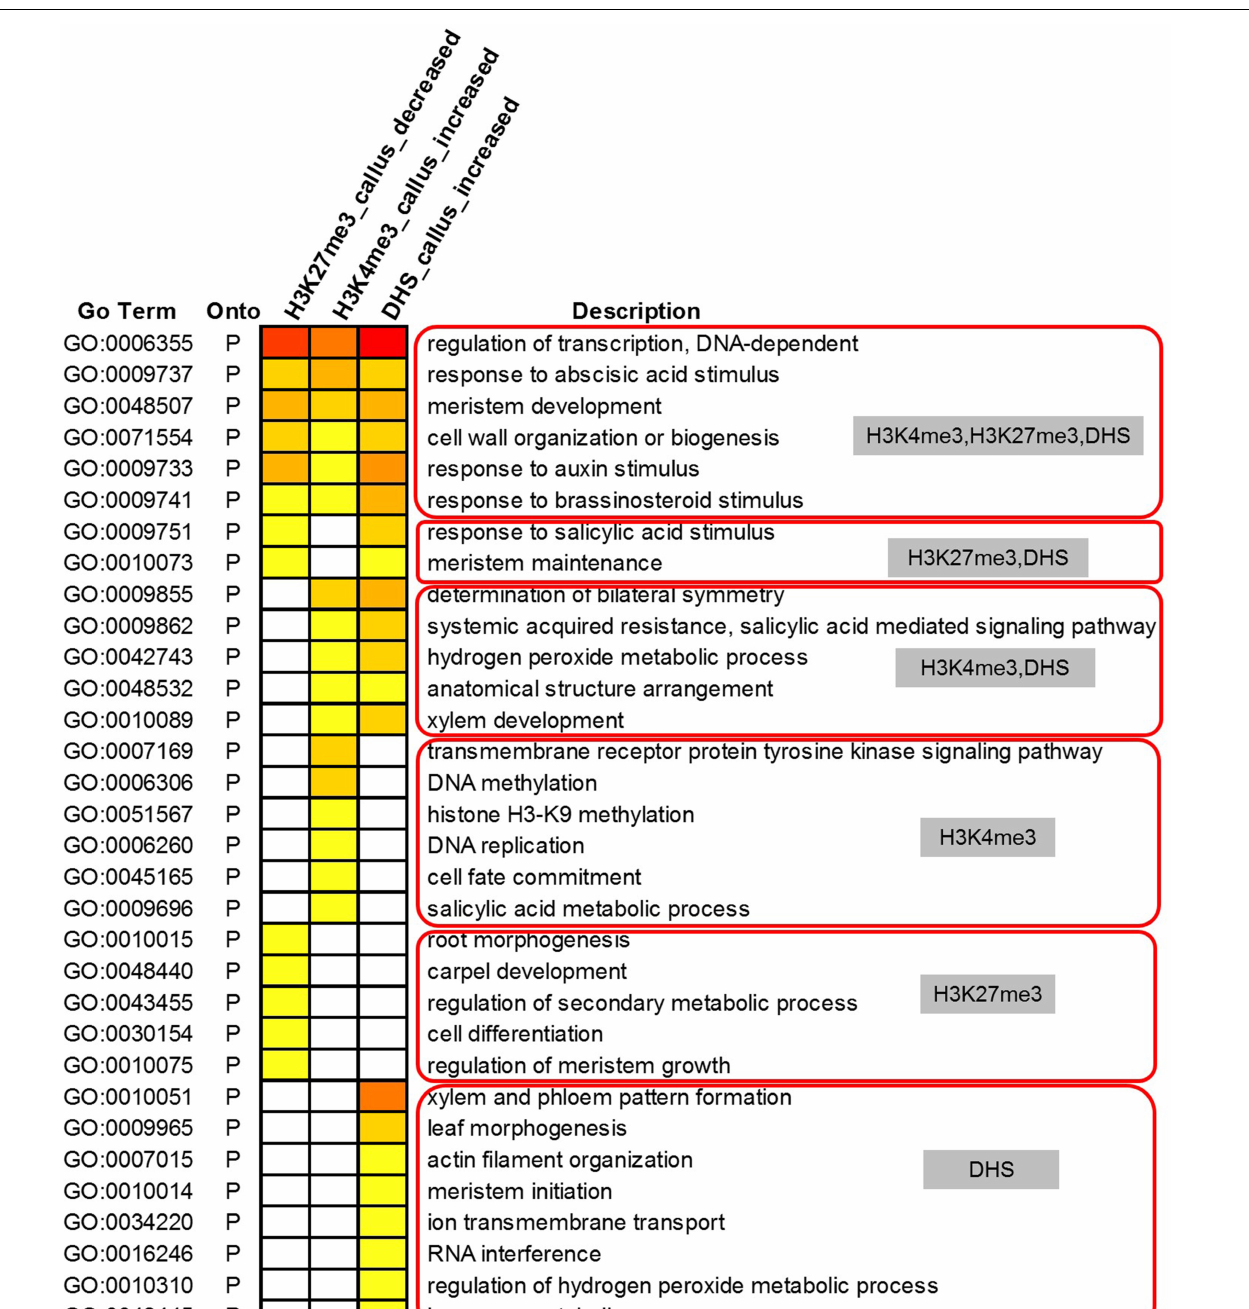
H3K4me3 was present, gene expression was highest, and when only H3K27me3 was deposited, the expression of the gene was significantly inhibited ( Figure 7B ). Gene expression is regulated by chromatin state; therefore, a transition between chromatin states may be involved in the tissue-specific expression of key developmental genes. We defined the seven different